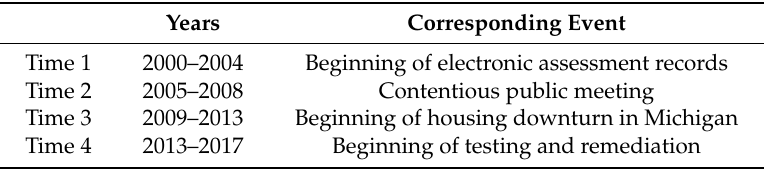
Table 2. Piecemeal time line variables and the corresponding event at the